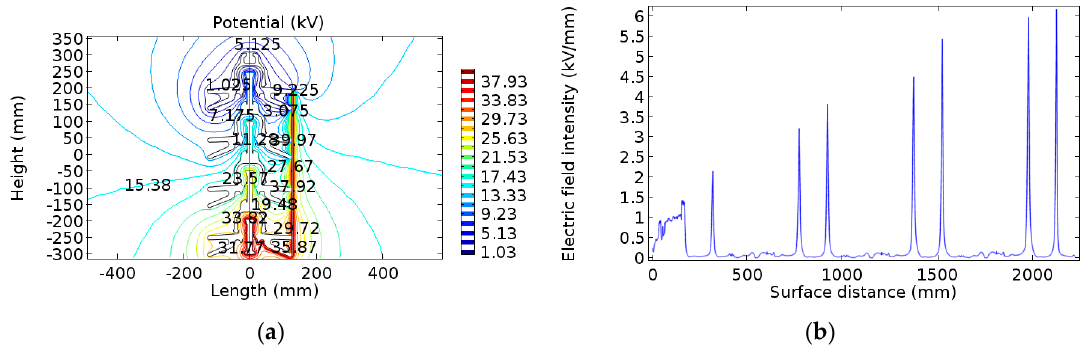
Figure 24. Simulation results of Bridge 4: ( a ) equipotential line distribution; ( b ) electric field distribution along insulator string.